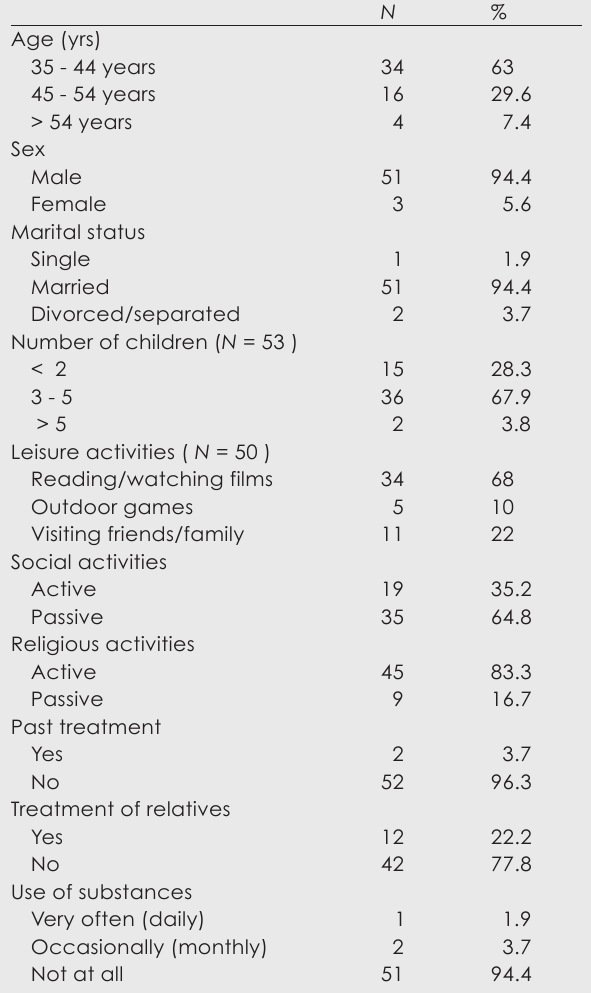
Table I. Sociodemographic characteristics of